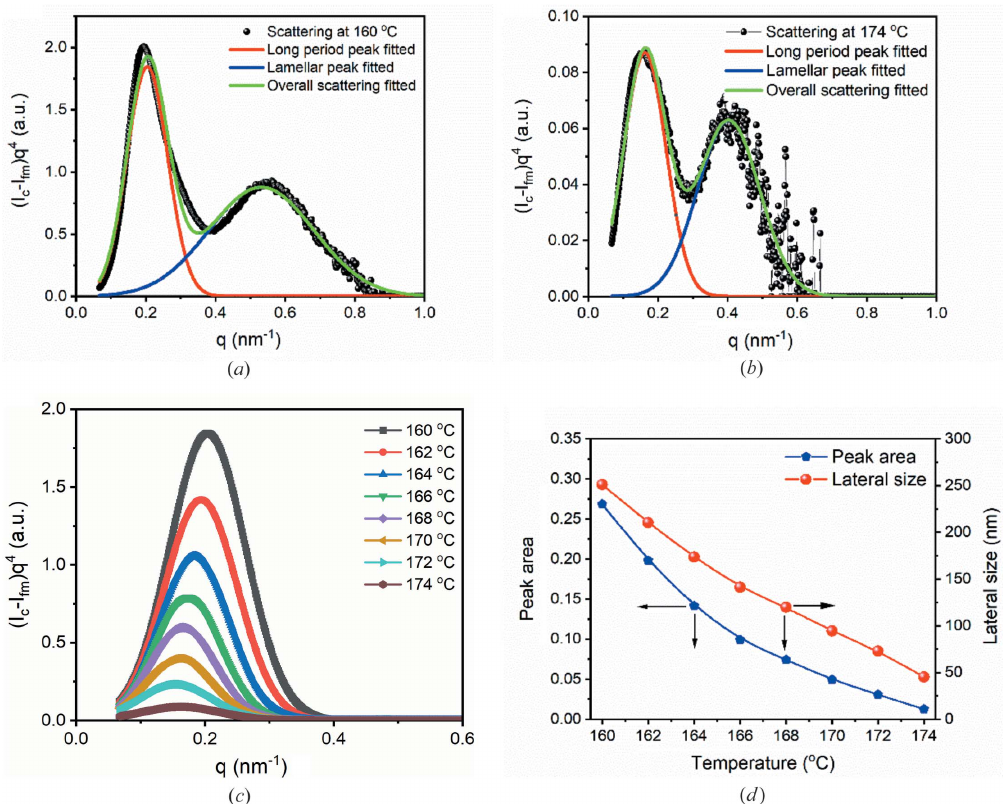
Figure 7 Multi-peak fitting for Iq 4 at ( a ) 160 and ( b ) 174 (cid:3) C. ( c ) First peaks obtained at temperatures between 160 and 174 (cid:3) C through fitting. ( d ) Changes in peak area and lateral size during